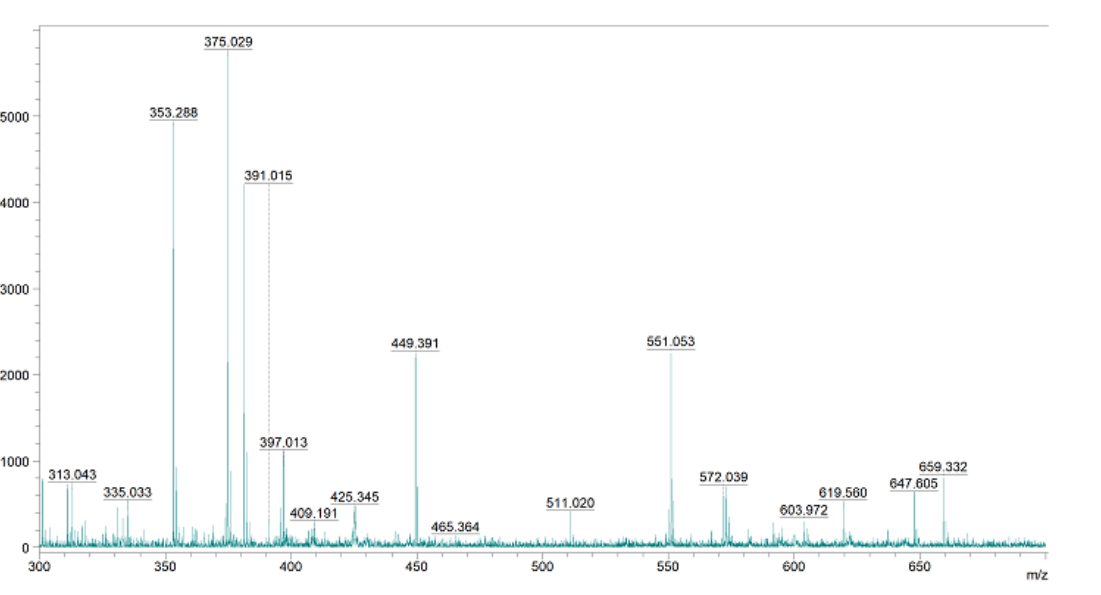
Figure 19. MS spectrum of the native hyaluronic acid. Table 2. Analysis of the characteristic peaks from the MS spectrum of native hyaluronic acid. m /